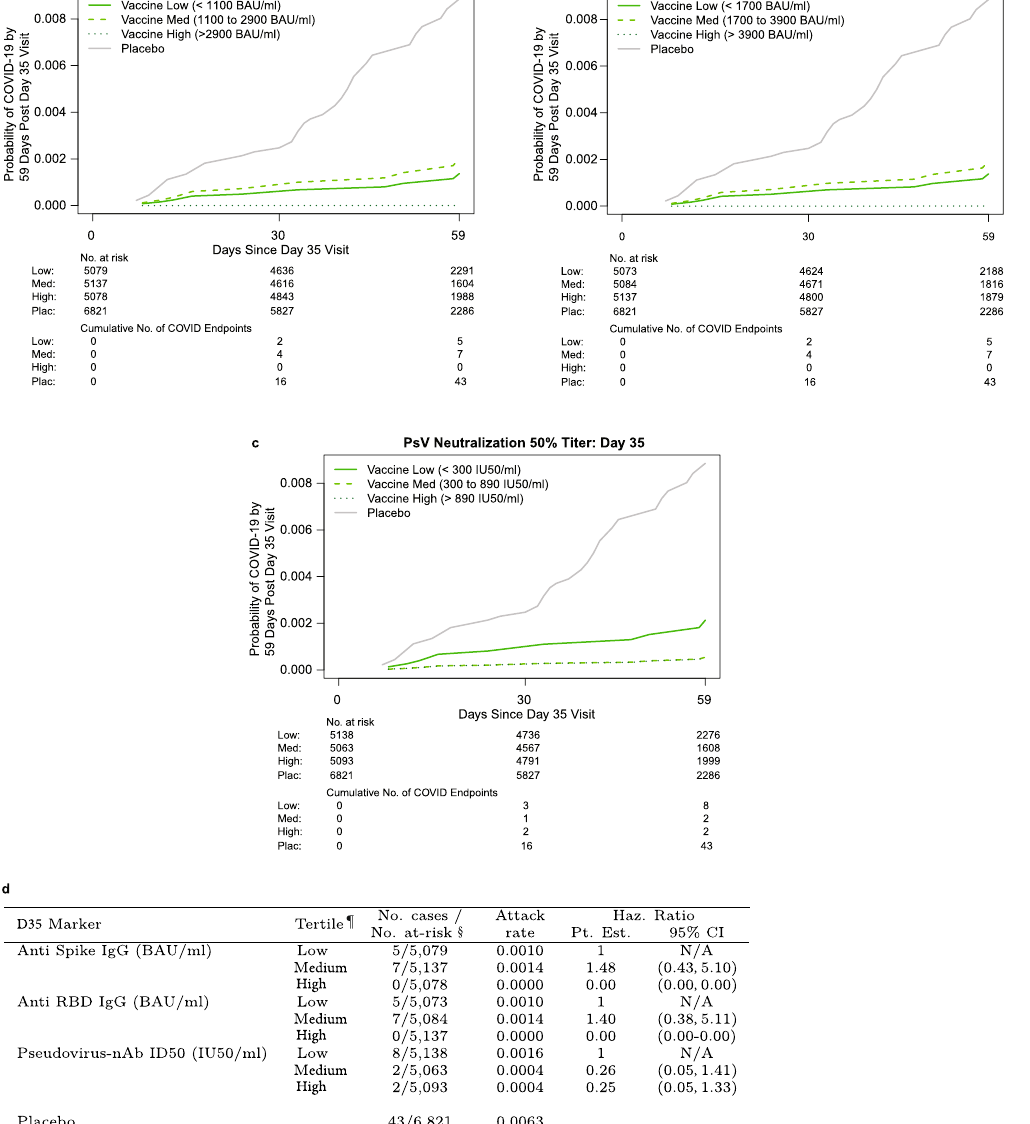
superimposed with the Medium tertile estimate. No p values for hypothesis tests areusedbecauseofthesmallnumberofCOVID-19breakthroughcases,asspeci fi ed in the Statistical Analysis Plan. Source data are provided in Fig. 3 Source Data fi le. D35, Day 35 visit; ID50, 50% inhibitory dilution; nAb neutralizing antibody; RBD receptor binding